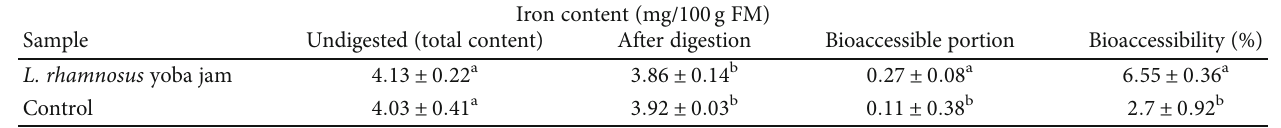
Table 3: In vitro digestion on iron content of the jam inoculated with L. rhamnosus yoba.